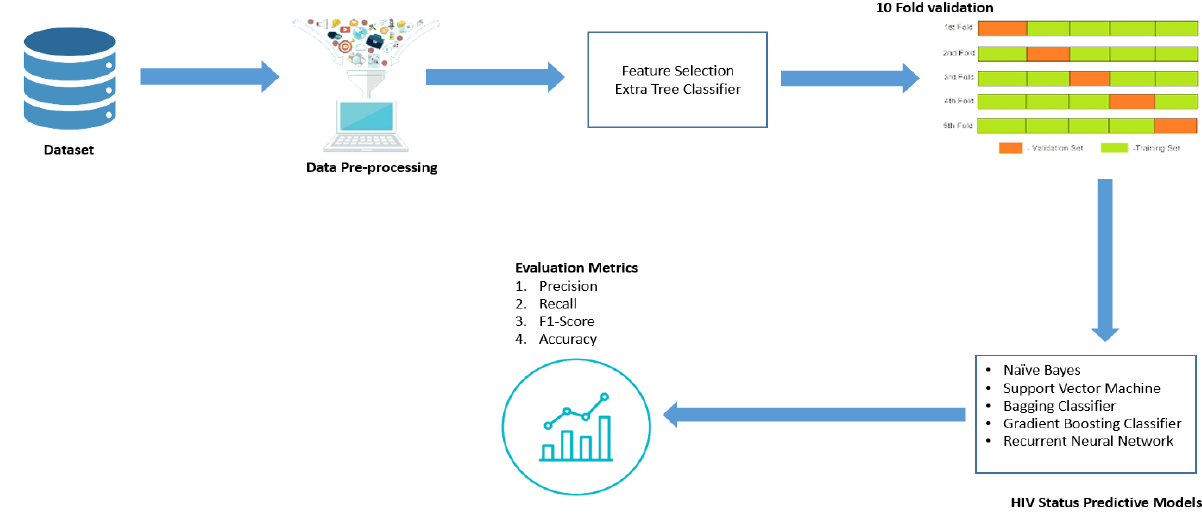
Figure 2. HIV status prediction models.